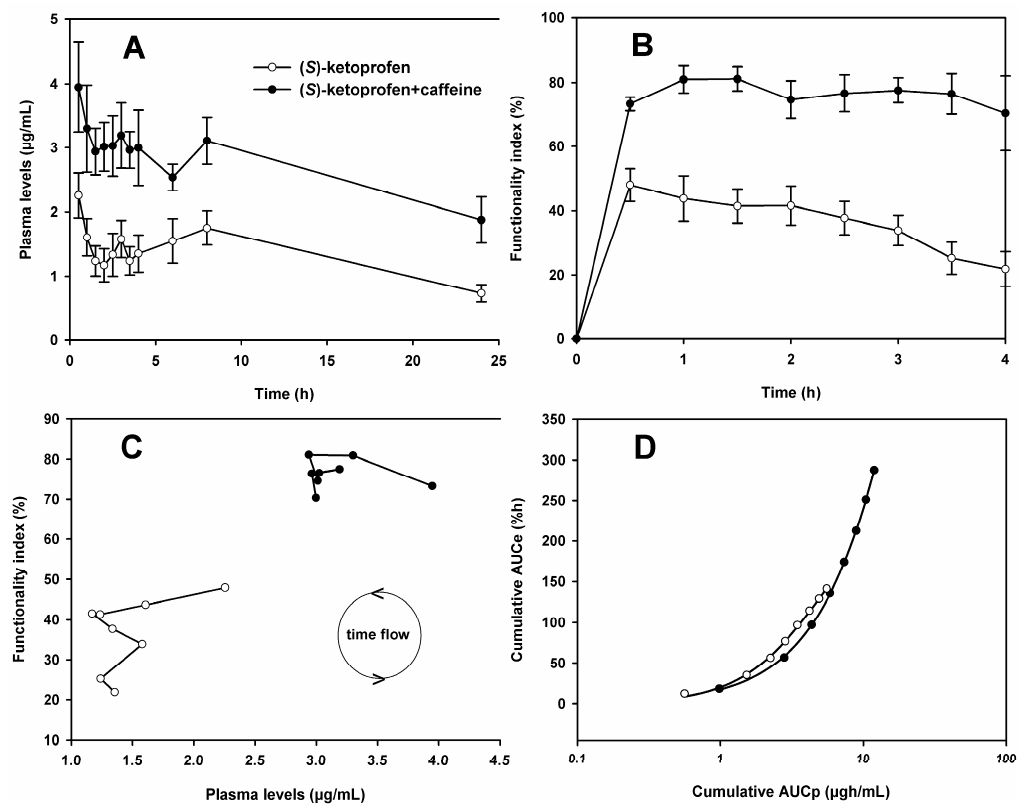
Figure 1. Results obtained after p.o. administration of ( S )-ketoprofen alone (3.2 mg/kg) and in combination with caffeine (17.8 mg/kg) to male Wistar rats (Mean ± SEM, n = 6/group). ( A ) Plasma concentration–time curves. ( B ) Antinociceptive effect–time curves. ( C ) Antinociceptive effect vs. plasma concentrations. ( D ) Cumulative AUCe as a function of cumulative AUCp, data adjusted to sigmoidal E max model. Table 1. ( S )-ketoprofen parameters. Mean ± SEM, n = 6. * p < 0.05.